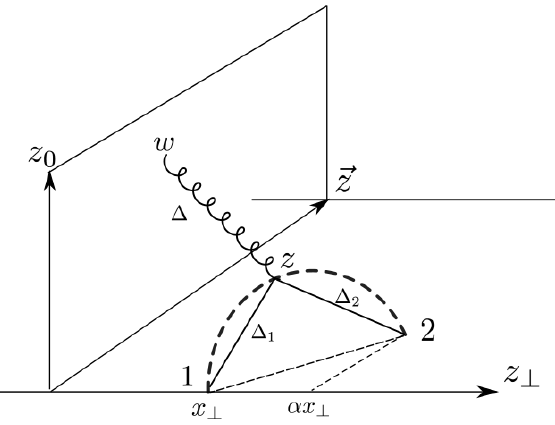
Figure 2 . The bulk-channel geodesic Witten diagram.